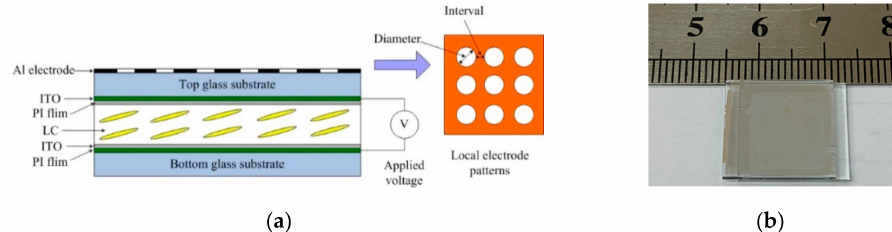
Figure 2. ( a ) The schematic structure of LC-MLA; ( b ) authentic LC-MLA 2D images by CCD.